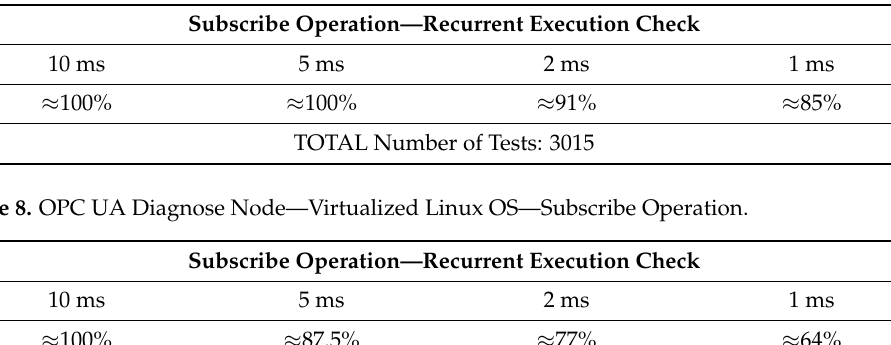
Table 7. OPC UA Control Node—Native Linux OS—Subscribe Operation.